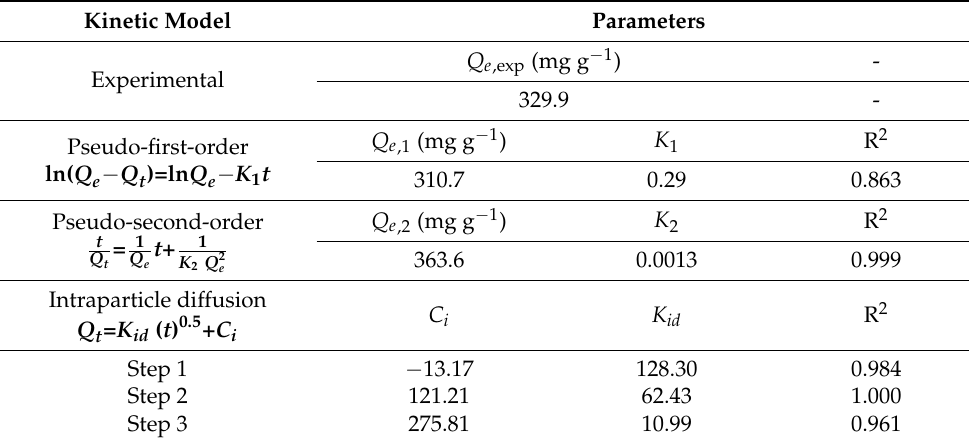
Figure 8. ( a ) Effect of contact time on the adsorption of doxycycline onto SA–DCNC-40 hydrogel beads and the kinetic model fittings: ( b ) pseudo-first-order, ( c ) pseudo-second-order, and ( d ) intra-particle diffusion. Table 3. Adsorption kinetic parameters for DOXY removal by SA–DCNC ‐ 40.